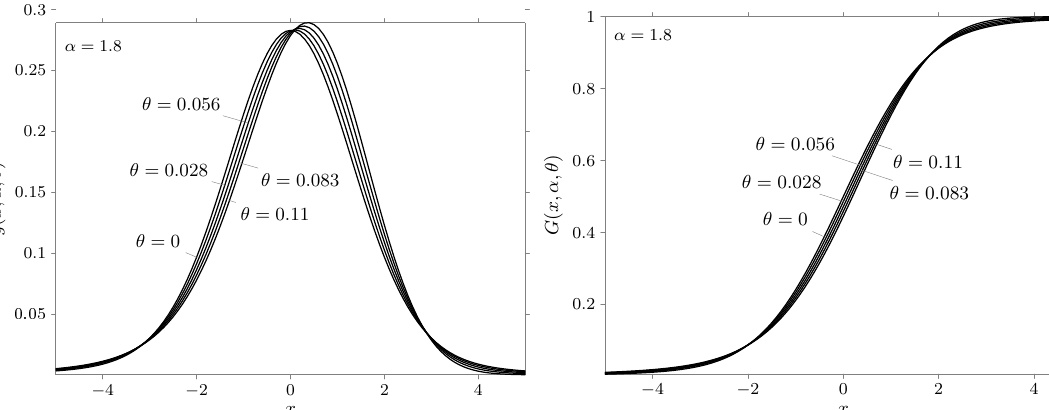
Figure 13. The probability density function g ( x , α , θ ) ( on the left ) ) and cumulative distribution function G ( x , α , θ ) ( on the right ) of a standard strictly stable law with α = 1.5 and specified values θ .